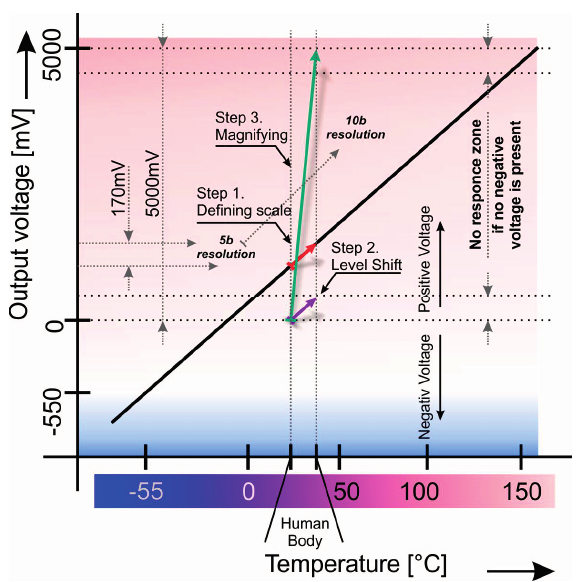
Figure 5. Principle of the presented